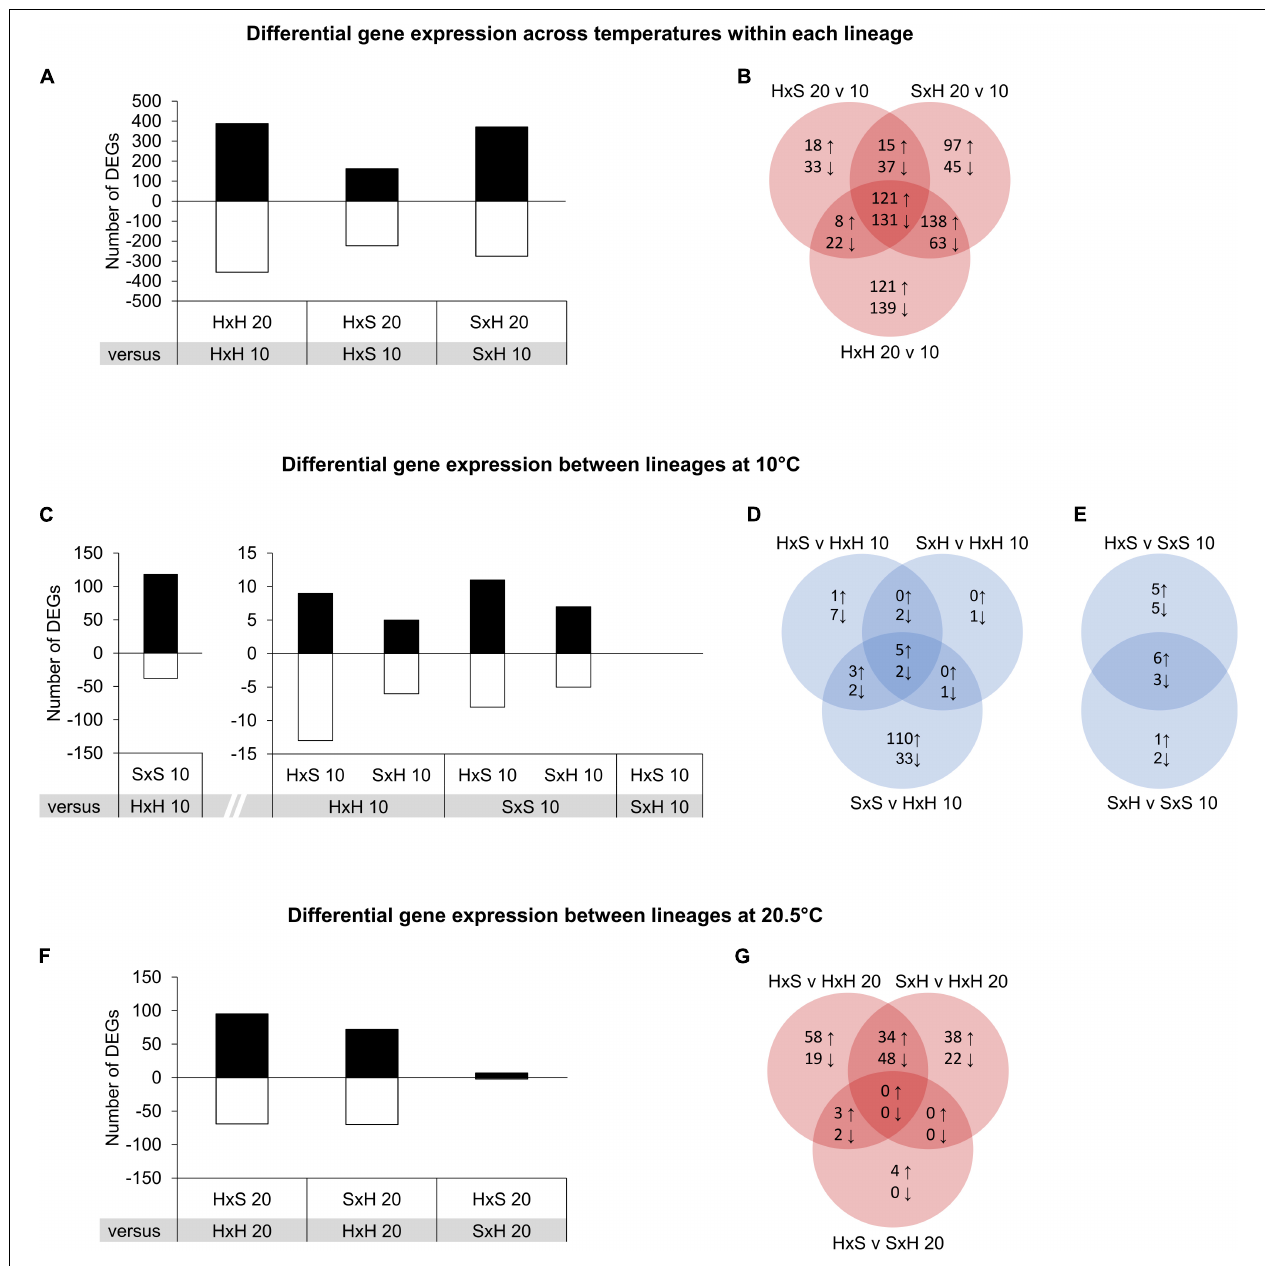
FIGURE 5 | Number of significantly up-regulated (positive, ↑ ) and down-regulated (negative, ↓ ) differentially expressed KEGG genes (DEGs; FDR < 0.01, log 2 FC ≥ 1) in Laminaria digitata sporophytes among comparisons of treatments in experiment 2 displayed as bar plots and Venn diagrams. Treatment abbreviations are composed as female × male from Helgoland (H) and Spitsbergen (S) at 10 ◦ C (10) and 20.5 ◦ C (20). (A,B) Comparisons within lineages across temperature treatments of 20.5 and 10 ◦ C to visualise temperature-dependent gene expression within lineages. (C–E) Comparisons among all lineages at 10 ◦ C to visualise baseline differences in gene expression. (F,G) Comparisons of all surviving lineages at 20.5 ◦ C to visualise lineage-specific temperature-dependent gene